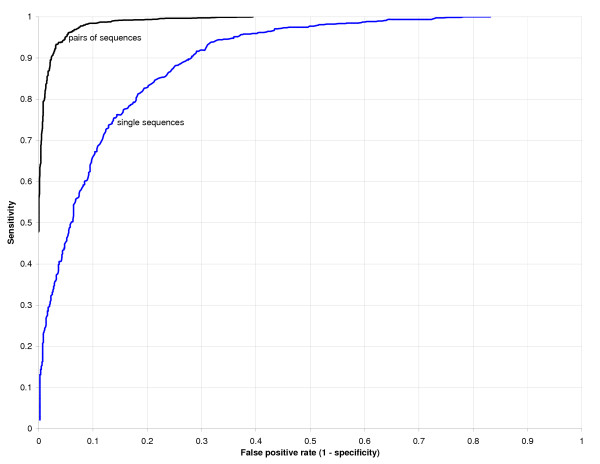
Comparison of the z score classification method using single sequences versus using sequence pairs. ROC curves comparing quality of classification based on single sequences versus based on sequence pairs, using the same free energy parameters for both. The single sequence curve (blue) is the same as in Figure 2. Black shows the best results for the sequence pair approach from Figure 3 (i.e. control generation by columnwise shuffle of global sequence alignment at parameter M = 8), to illustrate the difference in prediction quality.